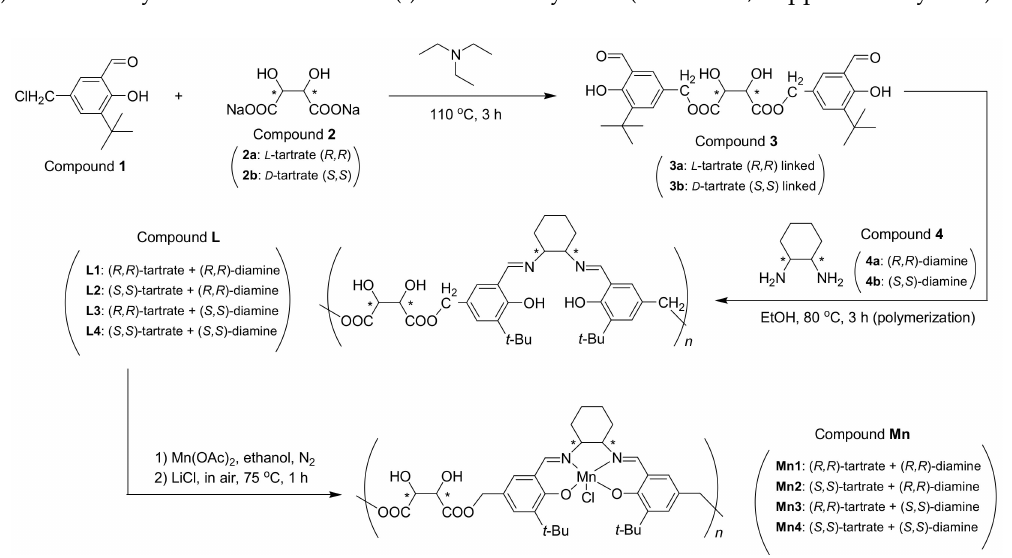
Scheme 1. Synthesis of (tartrate-salen)Mn(III) polymer